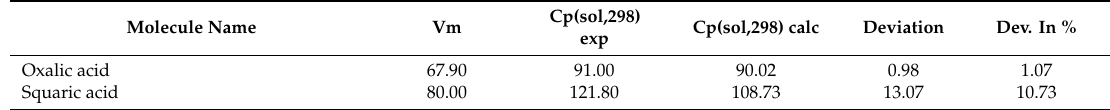
Table 10. Molecular volumes Vm (in A 3 ), experimental and calculated Cp(sol.298) (in J / mol / K) of 119 polyols and